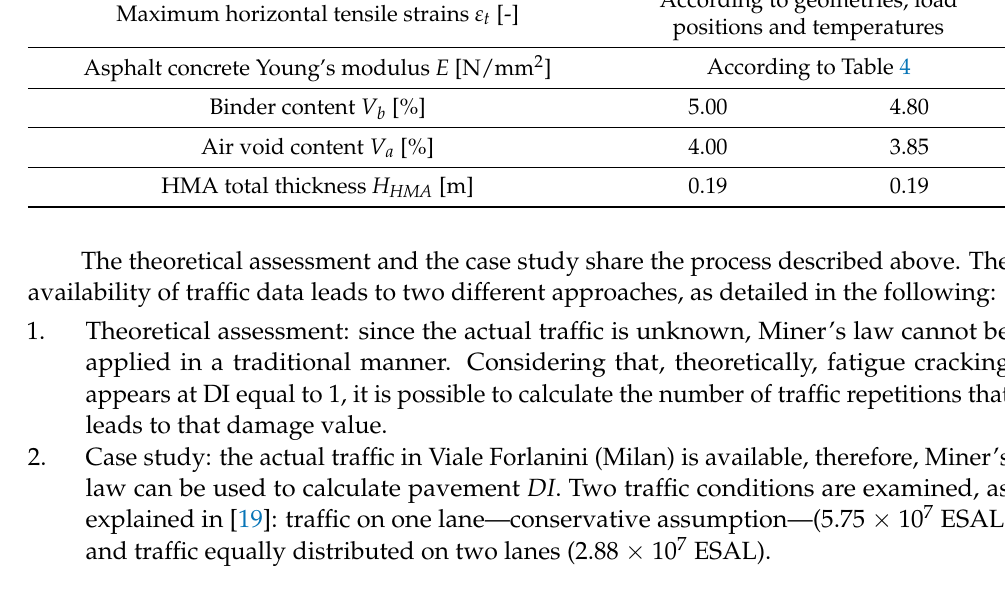
Table 5. Data for bottom-up cracking model.